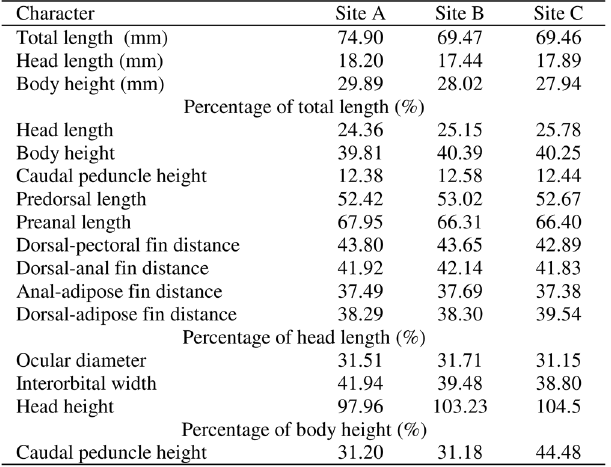
Table 3. Mean morphometric data and body proportions of Astyanax aff. bimaculatus .